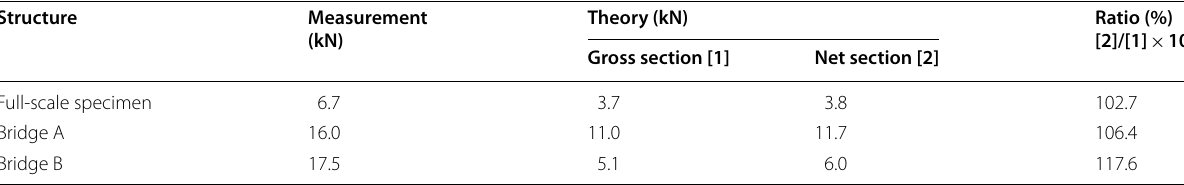
Table 6 Change in elastic shortening loss at mid‑span according to sectional area.